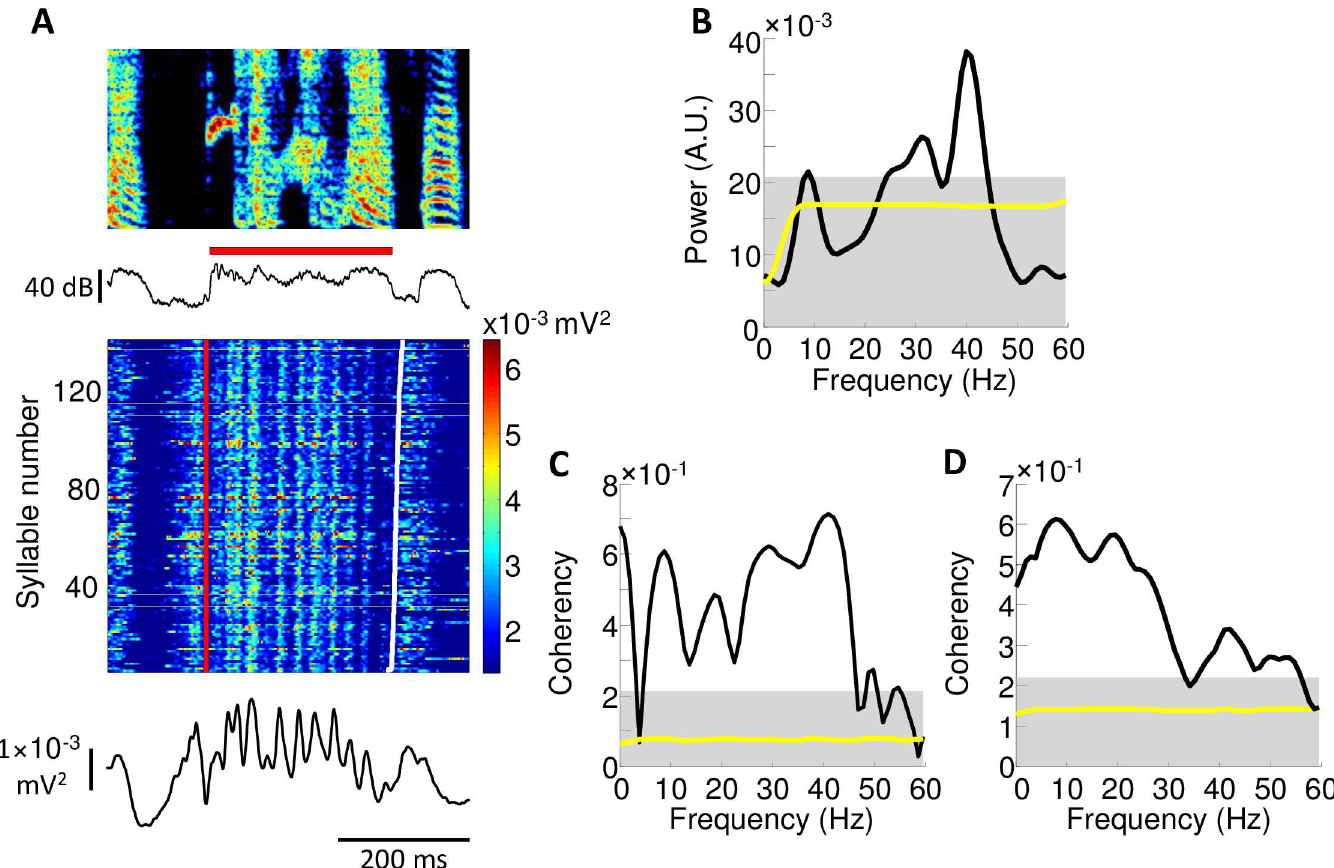
Fig 9. Rhythmicity during long syllables. ( A ) In many long syllables( > 150msin length), we observed rapid oscillations in Uva activity. ( B ) In these long syllables,we consistently observeda peak in the power spectrum of Uva activity at frequenciesin the gamma range. ( C ) Uva activity duringthese long syllablesis significantly coherent with song amplitudeacross a large frequency range (1-55Hz)and ( D ) across all birds when compared to null distribution (yellow), calculatedfrom randomly shuffled neuraldata (see Methods) (gray shadingindicates95% confidenceinterval for maxima anywherein this